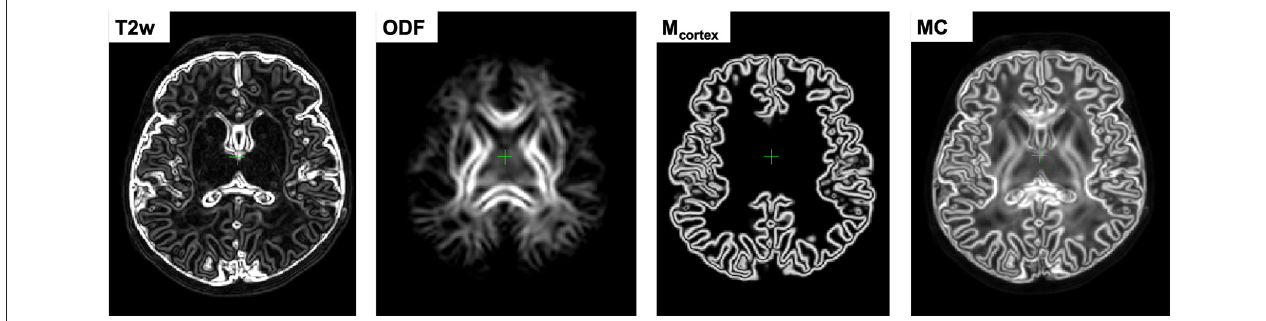
FIGURE 2 | An example of gradient-based certainty maps of T2w, ODF and cortex mask channels computed for one of the dHCP subjects along with the average MC gradient map used for normalization.